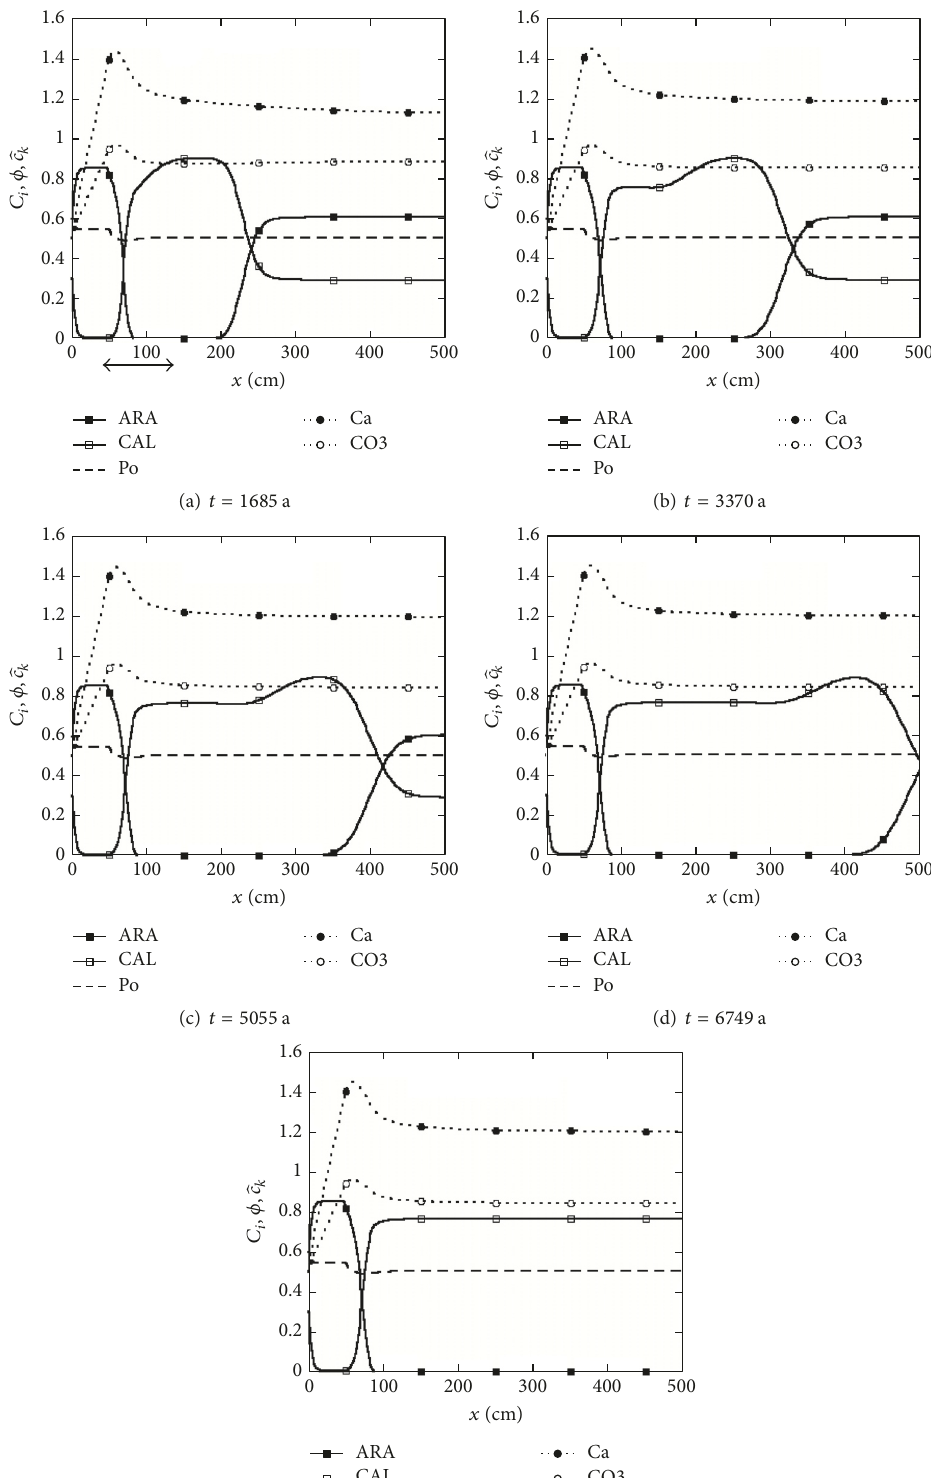
Figure 3: Numerical solution for scenario A with 𝜙 in = 0.5 and 𝜙 0 = 0.6. Aragonite and calcite composition, dissolved species concentrations and porosity fields at four different times (a–d), and final steady state profiles